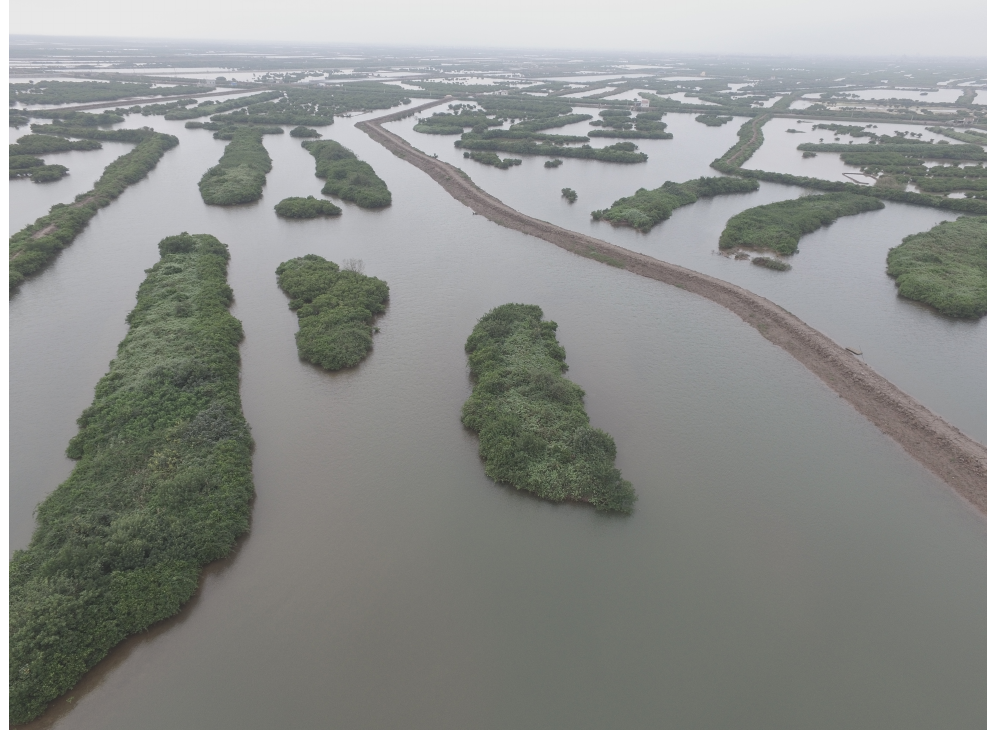
Figure 12. A drone photograph looking over part of the Xuân Thủy National Park, on the Red River Delta, Vietnam (March 2018). The photograph illustrates an area of aquaculture with highly fragmented mangroves.